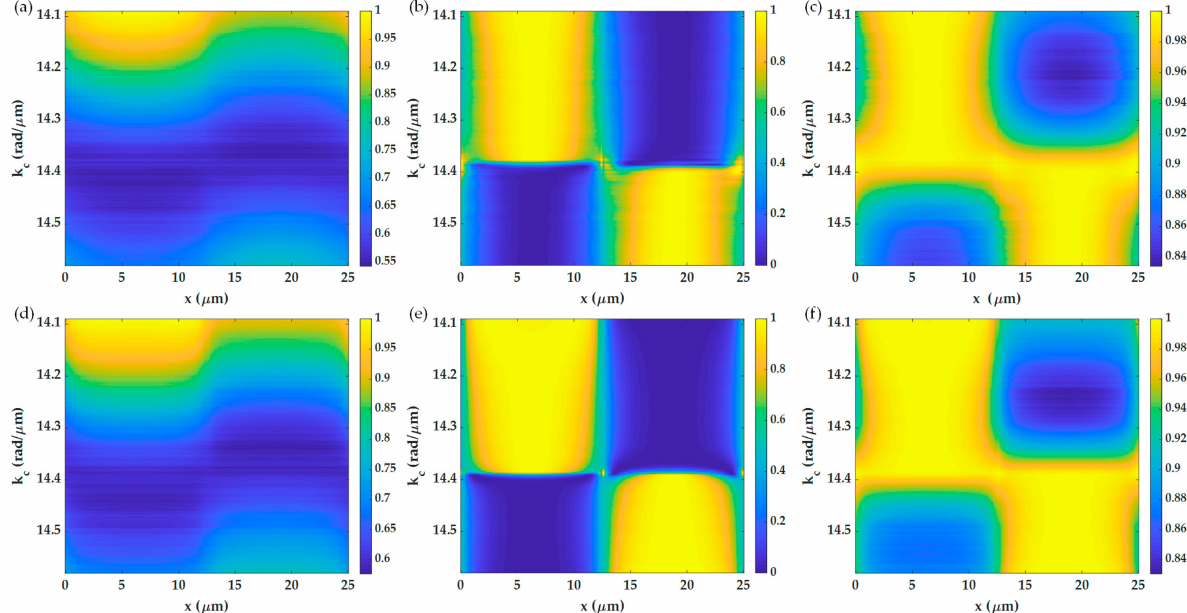
Figure 9. Shows line scans images at different annulus radius k c varying from 14.1 rad/ µ m to 14.6 rad/ µ m and the w of 0.06 rad/ µ m, equivalent to 0.1 FWHM of SPR dip. The sample was the 25 µ m grating period under the 1.7NA objective lens. ( a ) non-quantitative images of the grating for the x-polarization, ( b ) normalized image to the intensity range 0 to 1 for the x-polarization, ( c ) image contrast for the x-polarization, ( d ) non-quantitative images of the grating for the y-polarization, ( e ) normalized image to the intensity range 0 to 1 for the y-polarization, and ( f ) image contrast for the